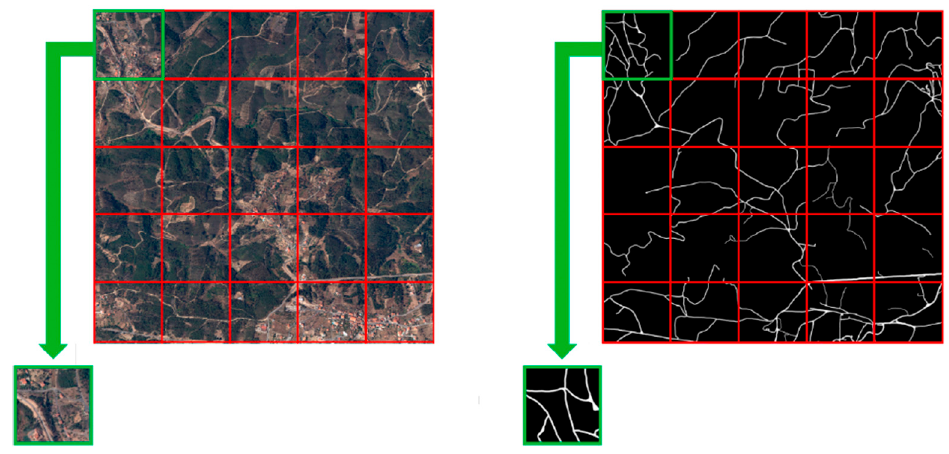
Figure 3. Original orthorectified aerial images ( left ) and the corresponding masks of size 1024 × 1024 pixels ( right ), each tile covering an area of 256 × 256 m 2 .